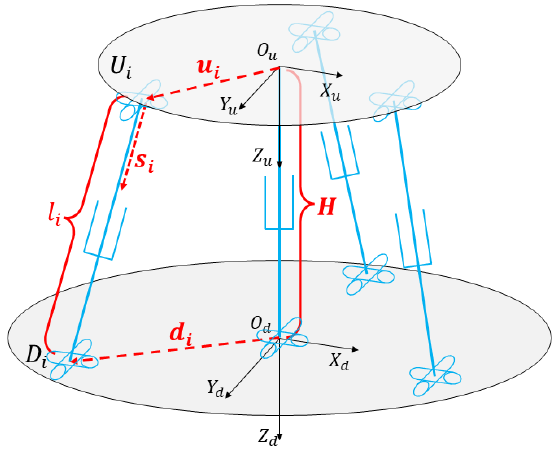
Figure 5. The stable platform’s frames.